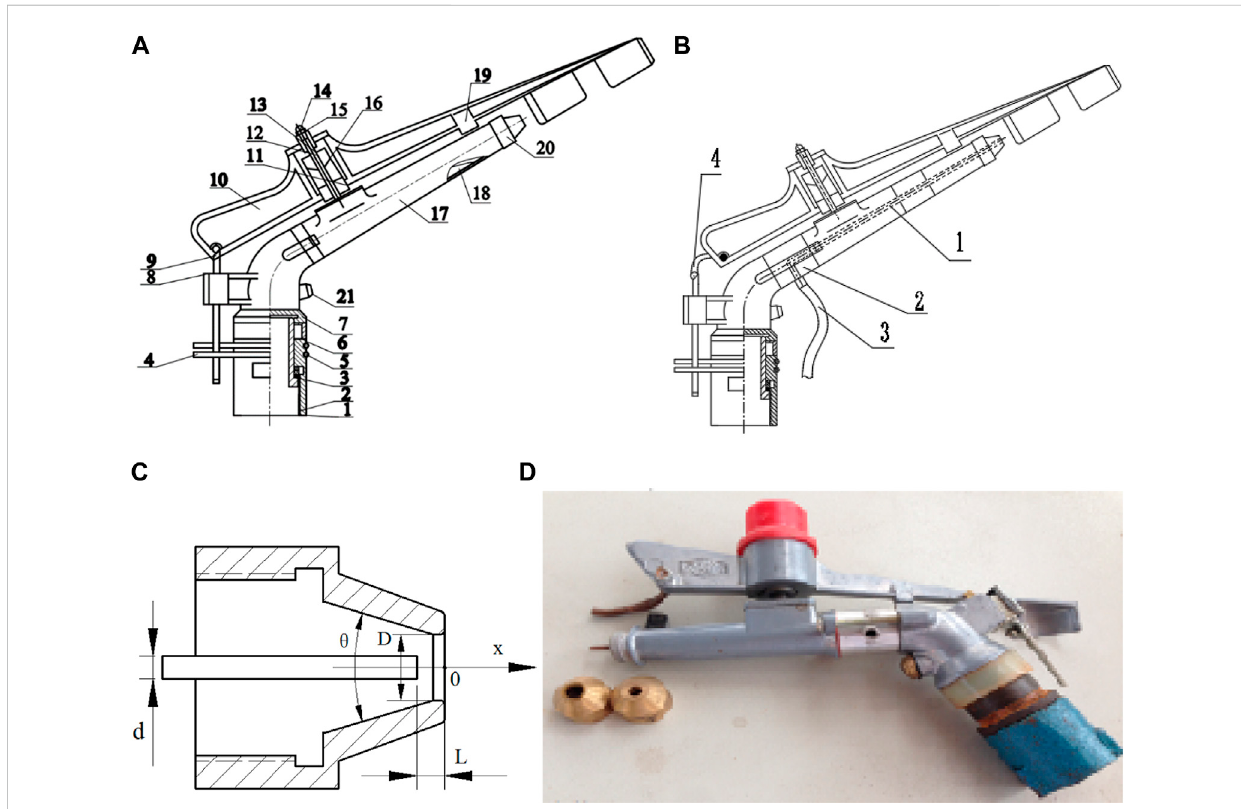
FIGURE 1 TheschematicsoftheISandAISstructures. (A) SchematicdiagramoftheIS(1Hollowbushing,2hollowshaft,3Antifrictionseal,4Limitring,5Sand- proof spring, 6 Spring cover, 7 Base, 8 Commutator, 9 Reverse hook, 10 Rocker arm, 11 Rocker arm Bushing, 12 Spring seat, 13 Rocker shaft bushing, 14 Position screw, 15 Rocker Shaft, 16 Rocker arm Spring, 17 Spray tube, 18 stabilizer, 19. Strike block, 20 Main nozzle, and 21 Auxiliary nozzle), (B) Schematic diagram of the AIS (1 Gas suction pipe; 2 Joint; 3 Plastic hose; 4 Extension rod), and (C) Schematic diagram of the main nozzle (D, diameter of theprimary nozzle;d, Diameter of the suction pipe; L, The adjusting length ofthe suctionpipe, Ɵ Degree of nozzle curve). (D) A prototype of the Aeration sprinkler.